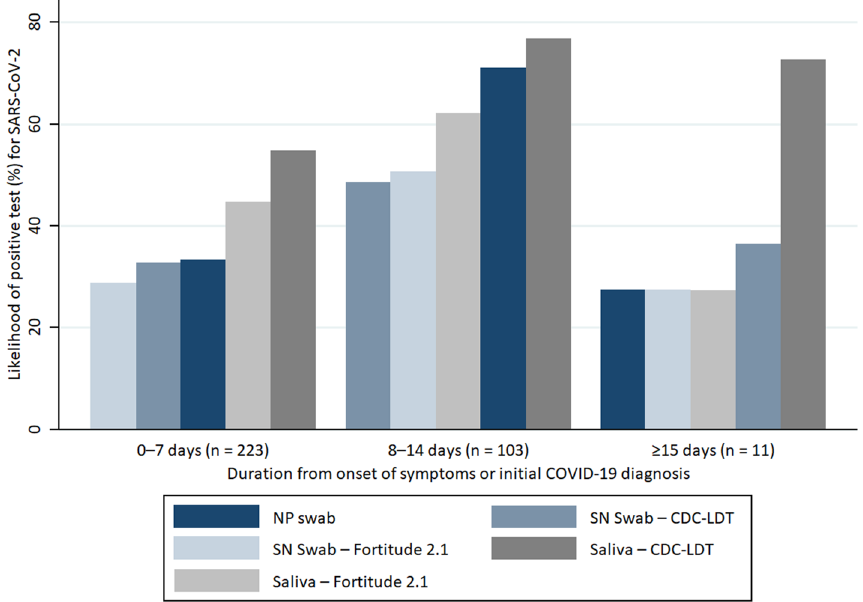
Figure 2. Likelihood of test positivity over time in confirmed COVID-19 subjects. The figure shows the likelihood of positivity for SARS-CoV-2 for nasopharyngeal (NP) swabs, self-administered nasal (SN) swabs, and naso-oropharyngeal saliva samples collected at 0–7 days, 8–14 days, and ≥ 15 days from the onset of symptoms (symptomatic subjects) or initial COVID-19 diagnosis (asymptomatic subjects). NP swabs were tested using via cobas SARS-CoV-2 or Centers for Disease Control and Prevention-Laboratory Developed Test